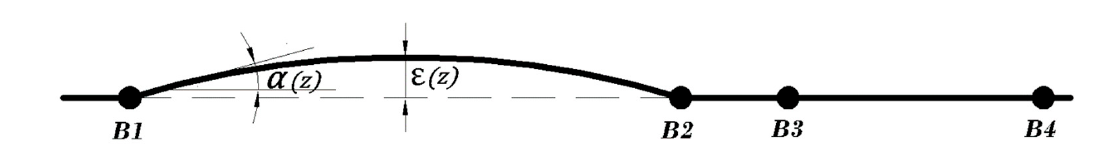
Figure 7. Schematic of defection assumed at shaft 1, Sh1, in shaft bow simulation.